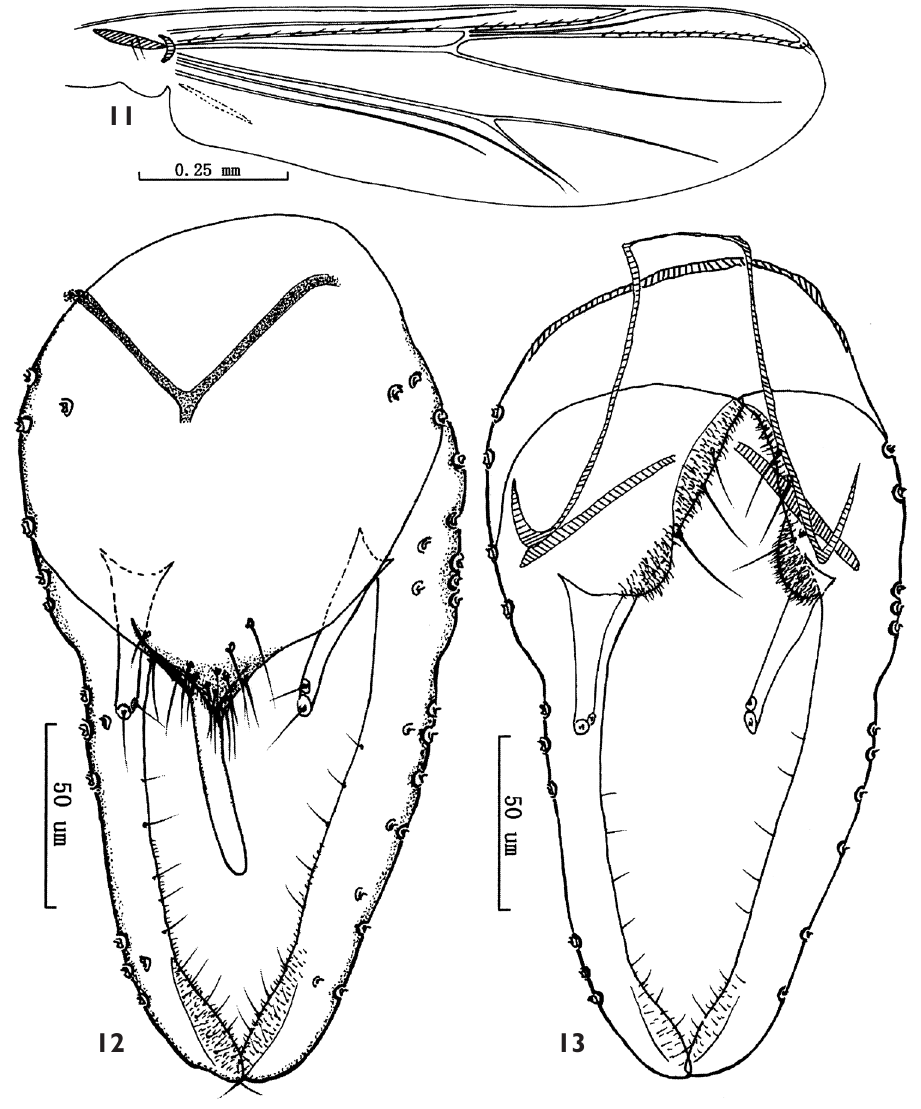
Figures11–13. Parachironomus poyangensis sp. n. 11 Wing 12 Dorsal view of hypopygium 13 Ventral view of